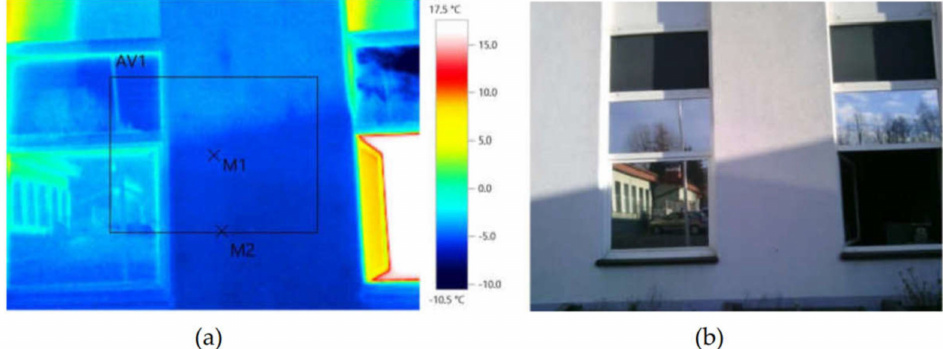
Figure 6. Temperature measurement of the wall from the outside using a thermographic camera ( a ) and the outside view of the wall ( b ).